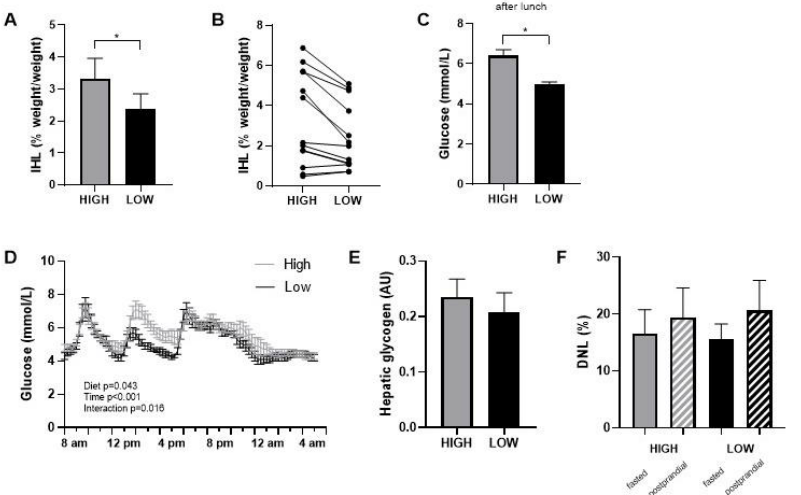
Figure 2. Intrahepatic lipid content (IHL) after a two-week high- or low-GI/SFA diet. ( A ) IHL content mean ± SEM. ( B ) individual IHL data ( n = 13). ( C ) Average glucose in interstitial fluid over the 3 h following lunch ( n = 10). ( D ) Continuous glucose measurements during standardized day 14 in the respiration chamber, after two weeks of a low-GI/SFA or high-GI/SFA diet. ( E ) Hepatic glycogen comparison after the low and high-GI/SFA diets, arbitrary units (AU) ( n = 10). ( F ) DNL as the percent of newly synthesized palmitate within the VLDL fraction in fasted state and after a 4 h meal test (postprandial). * p <